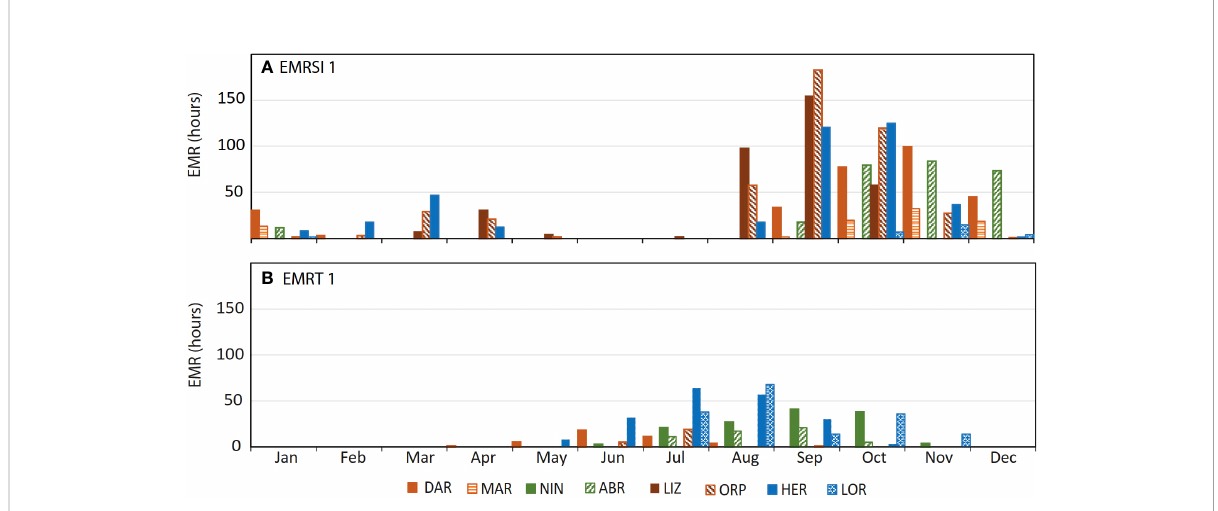
FIGURE 8 Seasonality by site of total hours of emersion mortality risk (EMR) (hourly data from 1992 – 2016) due to (A) high solar irradiance (EMRSI 1) and (B) low atmospheric temperature (EMRT w